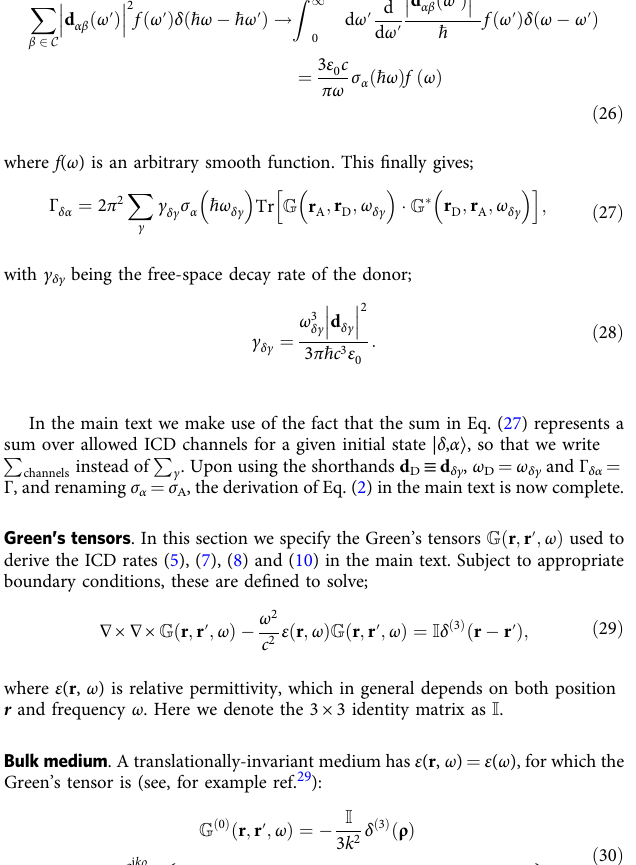
Fig. 3 where optical data from refs. 40,41 were used. The transition frequencies of hydrogen- and neon-like ions are publicly available in the NIST Atomic Spectra Database 37